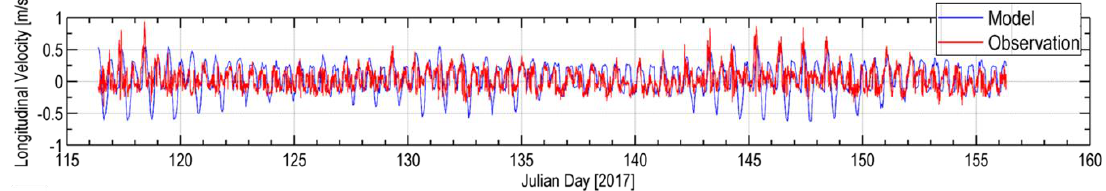
Figure 11. Comparisons of predicted and observed velocities just below HCB.